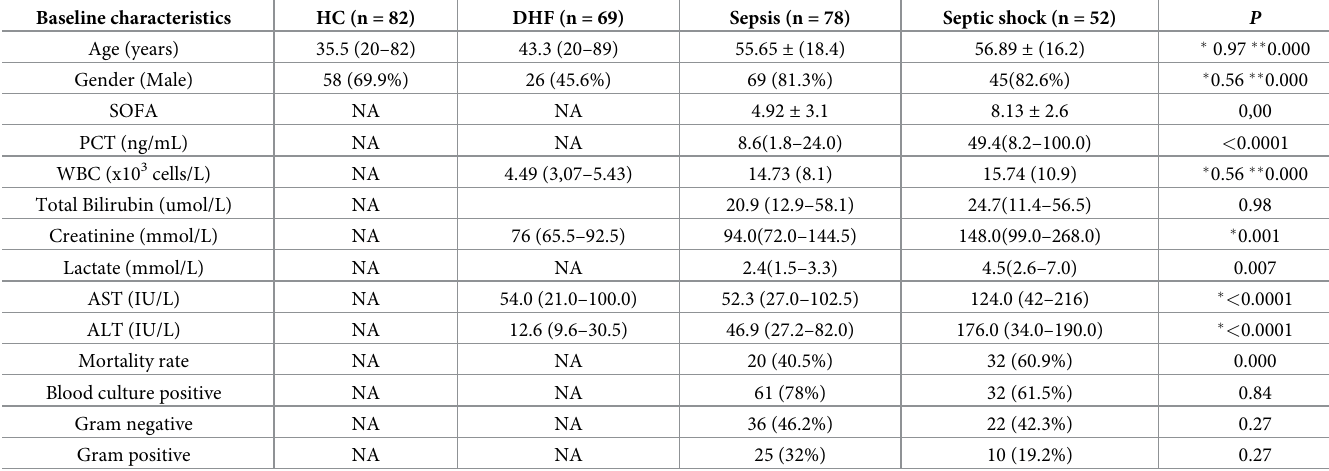
Table 2. Characteristics of study participants according to clinical